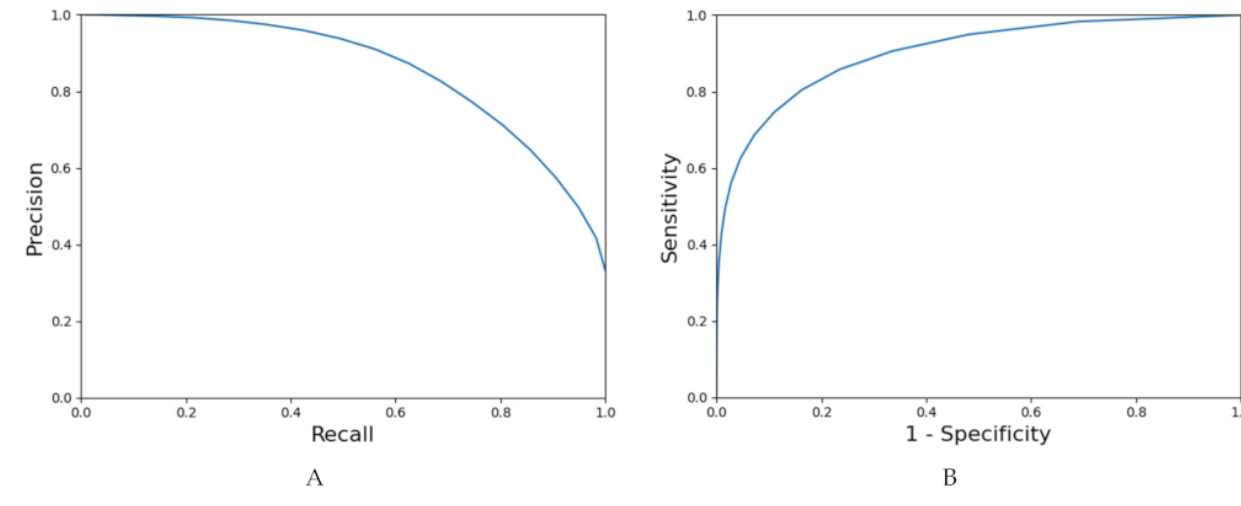
Figure 2. Precision-recall ( A ) and ROC curves ( B ).